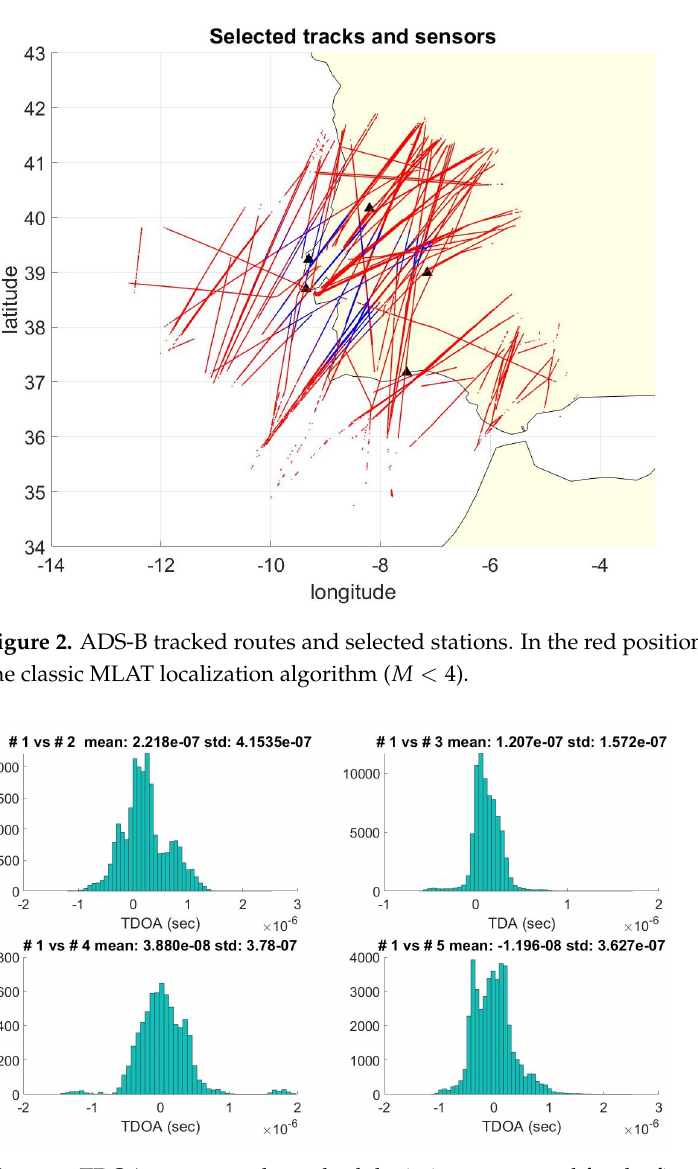
Figure 3. TDOAs means and standard deviations computed for the five